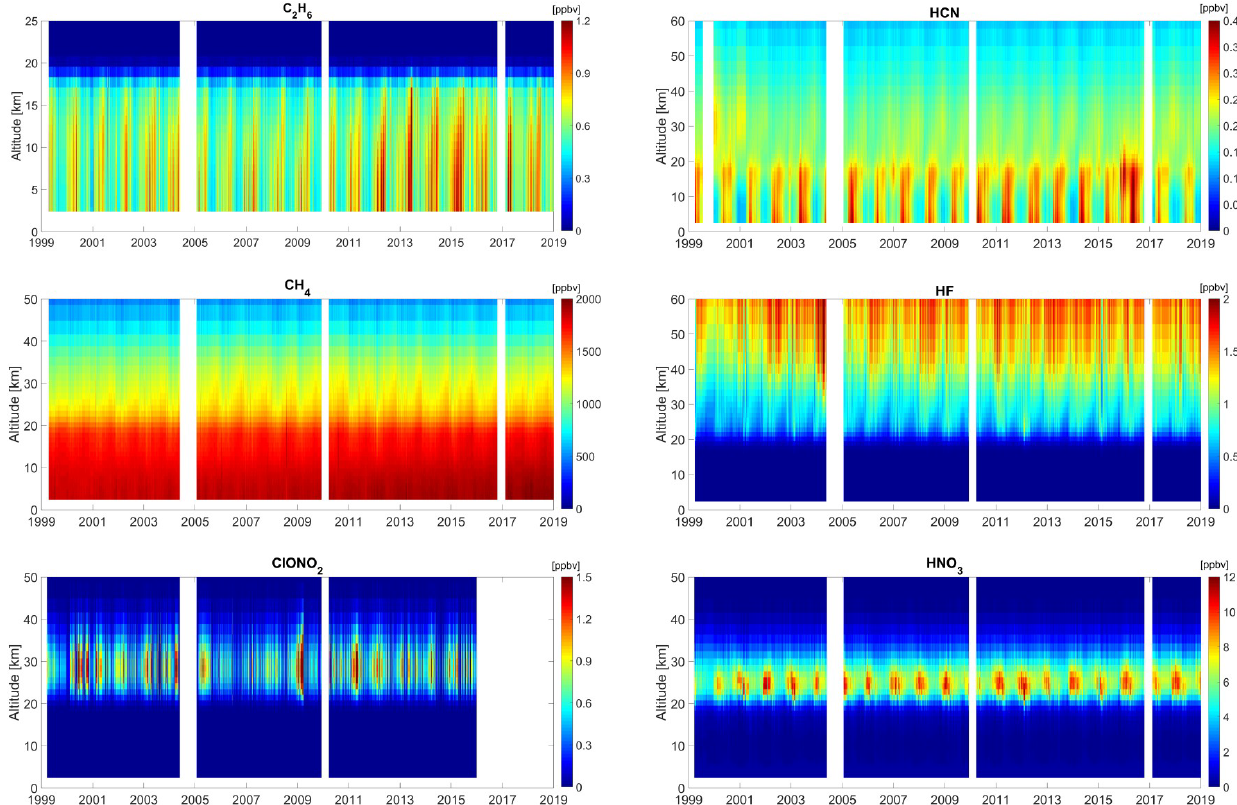
Figure 9. Time series of NDACC VMR vertical profiles at IZO from 1999 to 2018: C 2 H 6 , CH 4 , ClONO 2 , HCN, HF, and HNO 3 . Ordinate limits as in Fig. 3. Also note that the range of the coloured scale, showing VMR concentrations, has also been adapted for each trace gas. White areas correspond to data gaps due to instrumental issues (recall Table